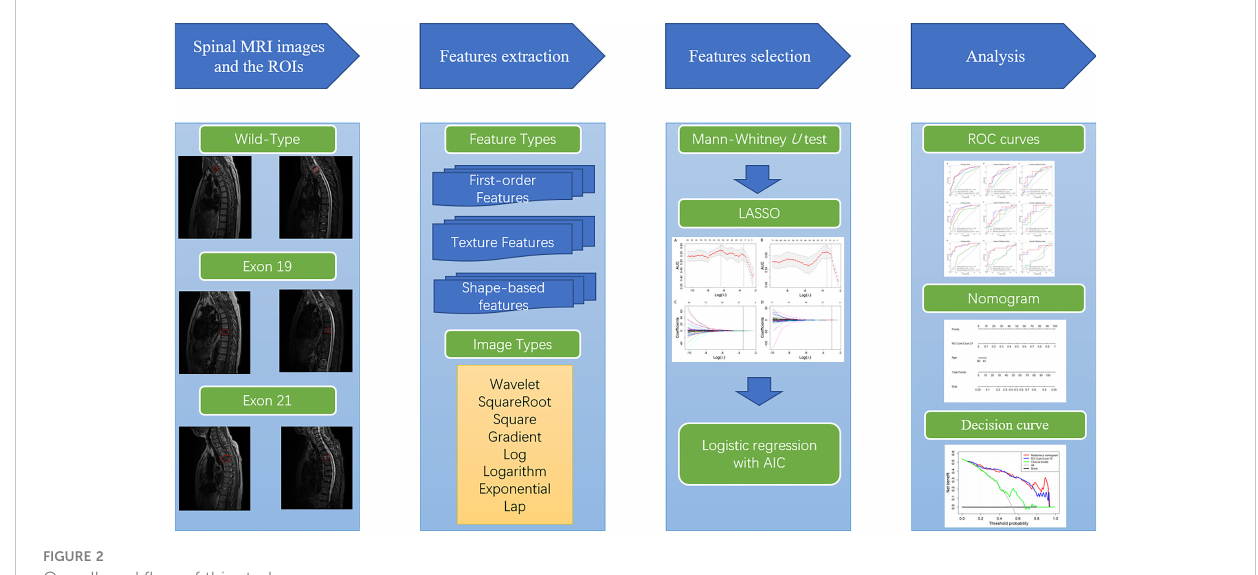
FIGURE 2 Overall work fl ow of this